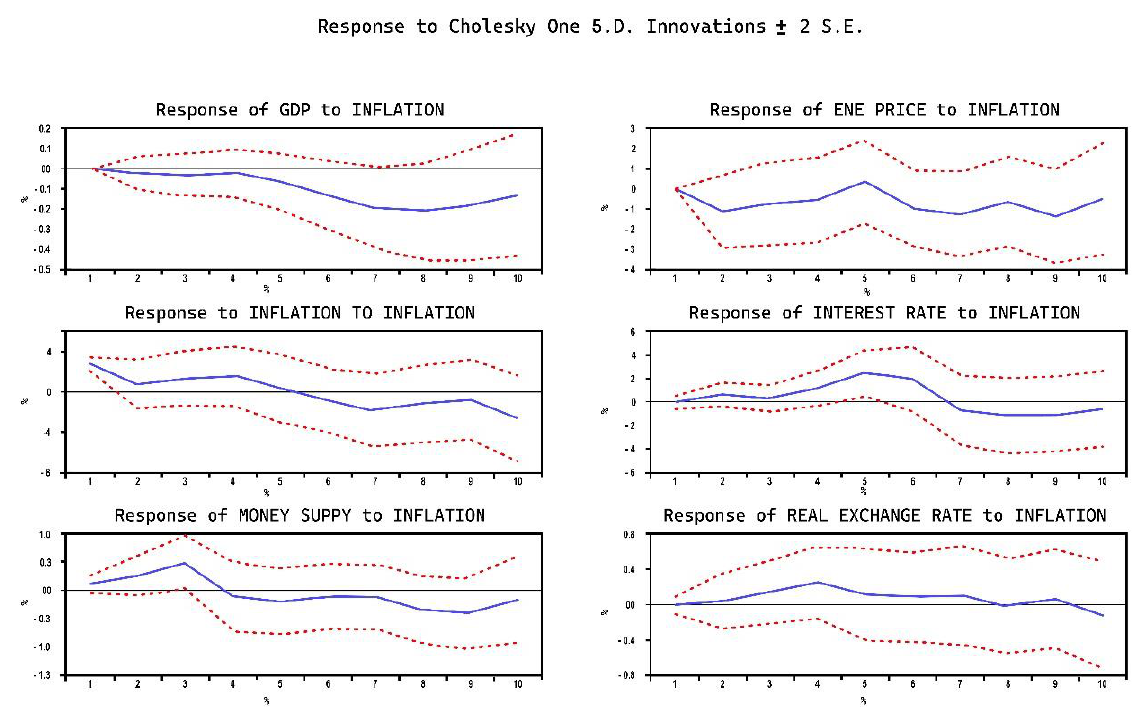
Figure 4. IRF to inflation rate (VAR IRF with intercept using annual data for 1980 – 2022).